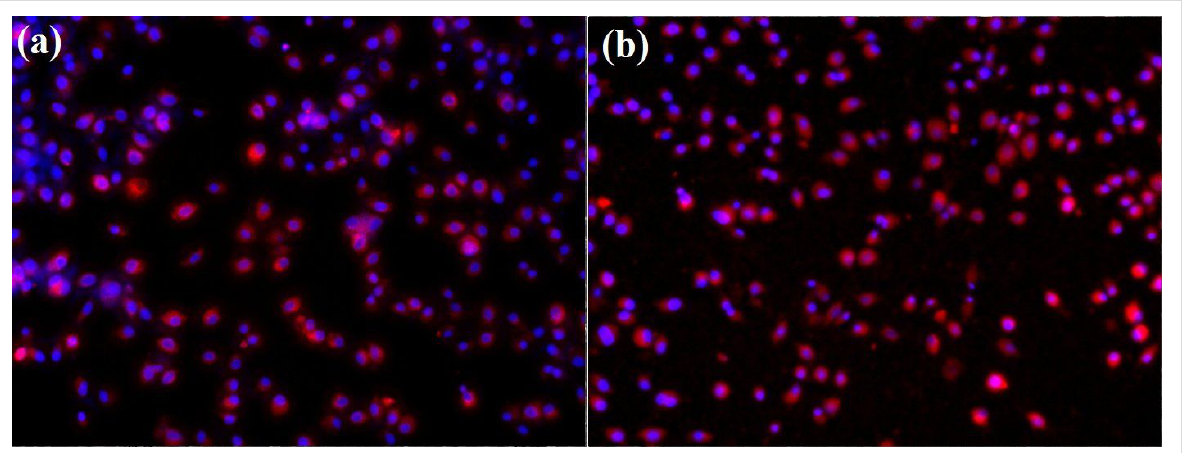
biofilms. MAPLE deposited thin films interfere with biofilm formation both in the initial phase and during biofilm matura- tion. S. aureus (Figure 7) biofilms were significantly impaired at all tested points of time, while P. aeruginosa (Figure 8) biofilms are especially affected after 24 and 48 h of incubation.